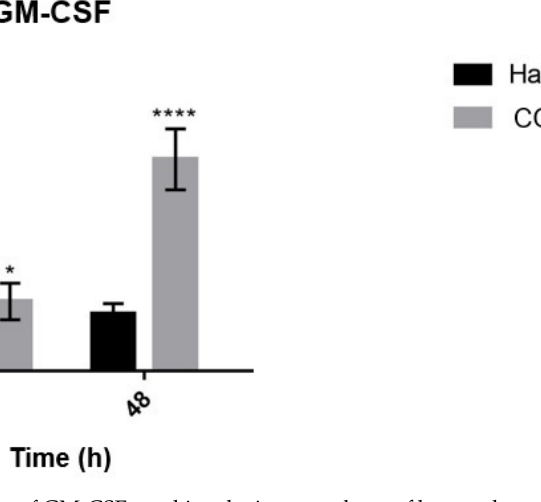
Figure 6. Quantification of GM-CSF cytokine during co-culture of human keratinocytes and T. rubrum . Cultured keratinocytes as used as control (HaCat). COC indicates co-culture with conidial phase of T. rubrum . Significantly different values are shown by asterisks, and were determined using ANOVA followed by Turkey’s post hoc test (* p < 0.05; **** p < 0.0001).